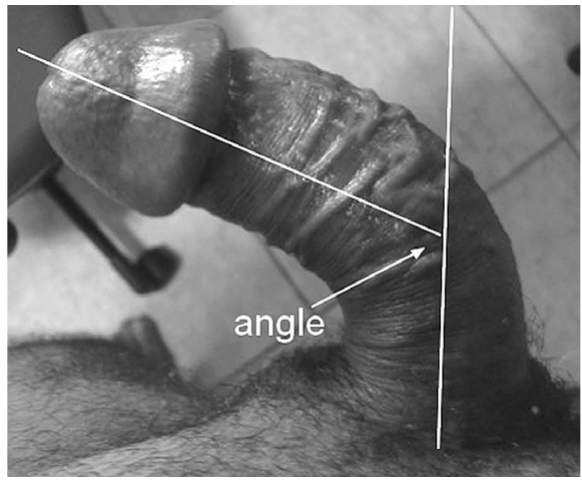
Figure 1 - Measurement of the angle based on patient’s